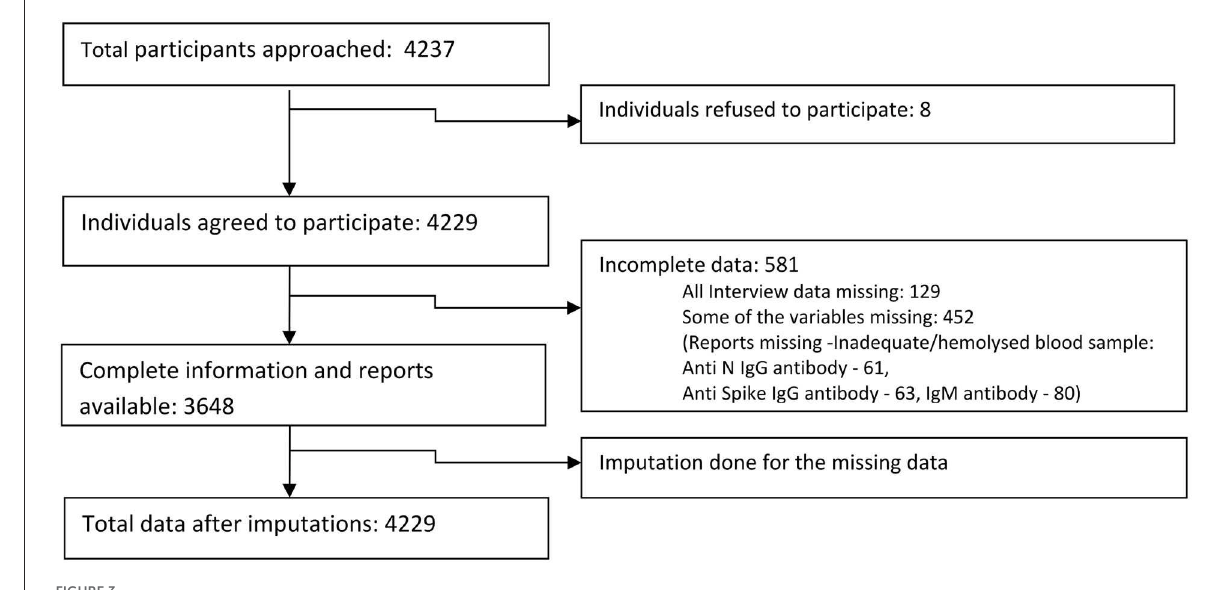
FIGURE3 Participant flow